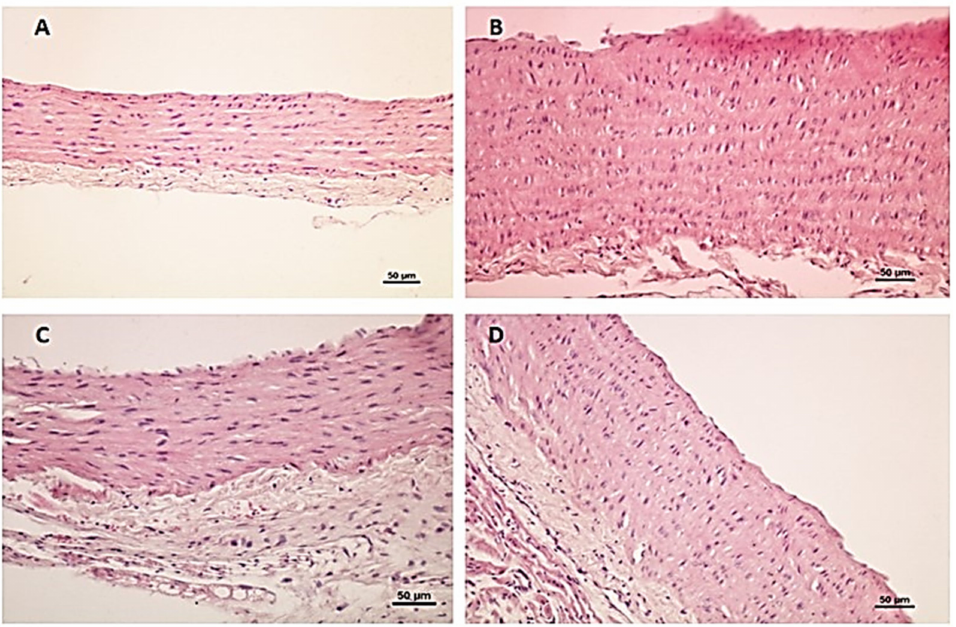
Figure 2. Histological examination of the aorta of the different studied groups. ( A ) A section from the aorta of a control rat showing a thin wall formed of tunica intima, tunica media, and tunica adventitia. Tunica intima reveals simple squamous endothelium with underlying lamina propria. Tunica media is formed of concentrically arranged smooth muscle with parallel internal elastic membranes. Tunica adventitia shows vasa vasorum. ( B ) A section from the aorta of a diseased rat showing loss of endothelial cells, and thickening of tunica intima and media with protrusion of intima into the lumen. ( C ) A section from the aorta of a diseased rat showing apparent thickening of tunica adventitia with presence of fat cells and inflammatory cells and congested vasa vasorum. ( D ) A section from the aorta of treated rats showing the relative improvement of the wall, apart from some lost endothelial